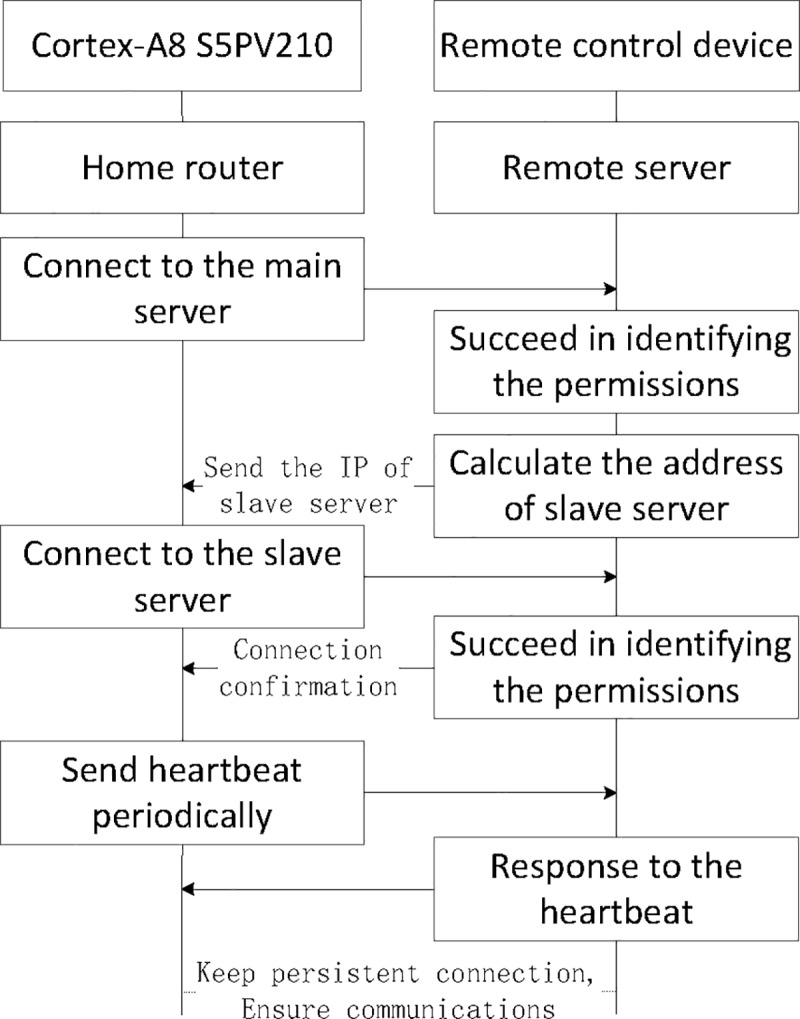
The server connection process.